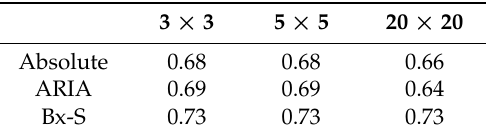
Table 1. ROC AUC values for each method for boxcar window sizes 3 × 3, 5 × 5 and 20 × 20. ROC AUC are shown for 200 m × 220 m aggregate classifier surfaces.